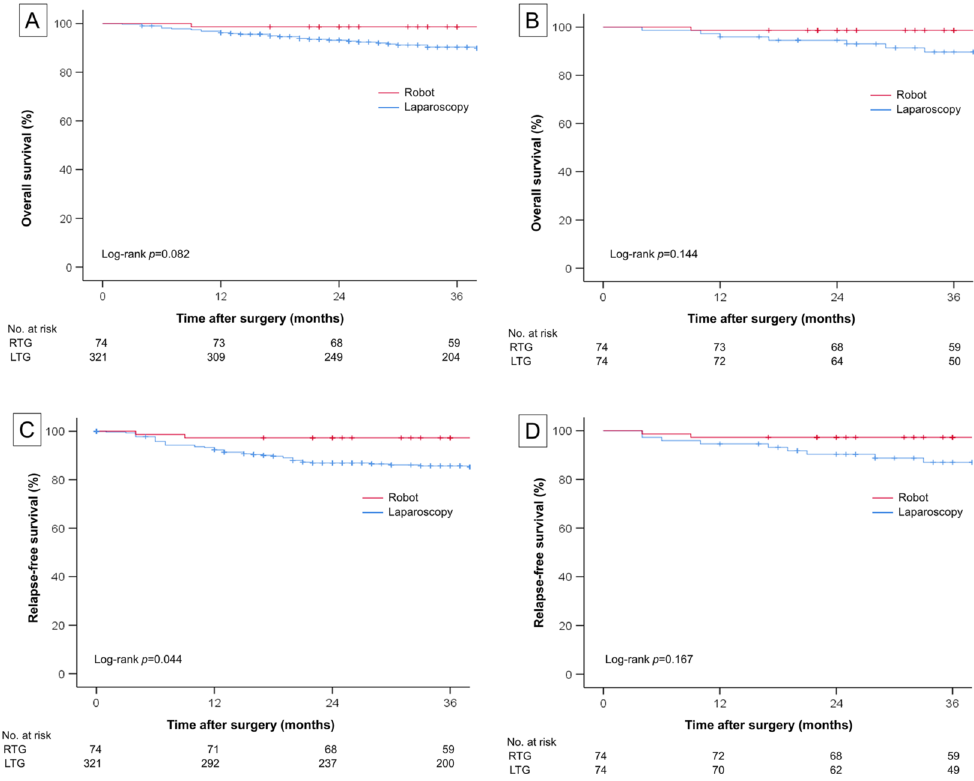
Figure 2. Kaplan–Meier curves for 3-year overall and relapse-free survival. ( A ) 3-year overall survival of the entire cohort. ( B ) 3-year overall survival of the matched cohort. ( C ) 3-year relapse-free survival of the entire cohort. ( D ) 3-year relapse-free survival of the matched cohort. RTG robotic total gastrectomy, LTG laparoscopic total